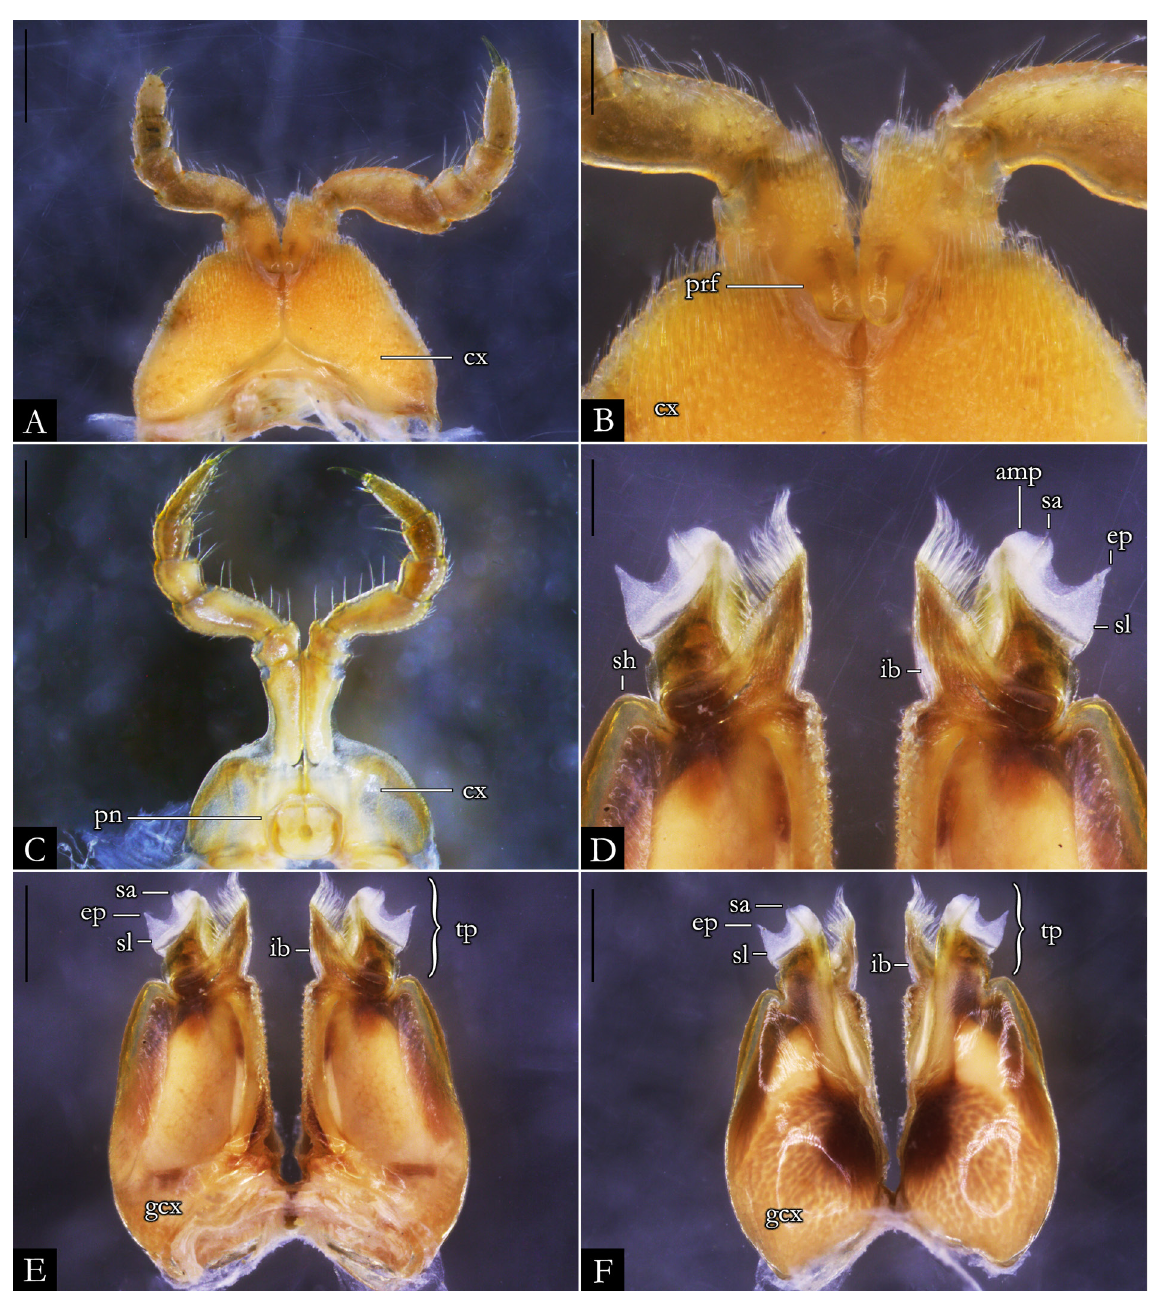
Fig. 57. Pseudonannolene caatinga Iniesta & Ferreira, 2014, ♂ (IBSP 2166). A . First leg-pair. B . Detail of prefemur. C . Second leg-pair. D . Detail of telopodites, in anal view. E . Gonopods, in anal view. F . Gonopods, in oral view. Abbreviations: see Material and methods. Scale bars: A, C = 0.5 mm; B, D–F = 0.2